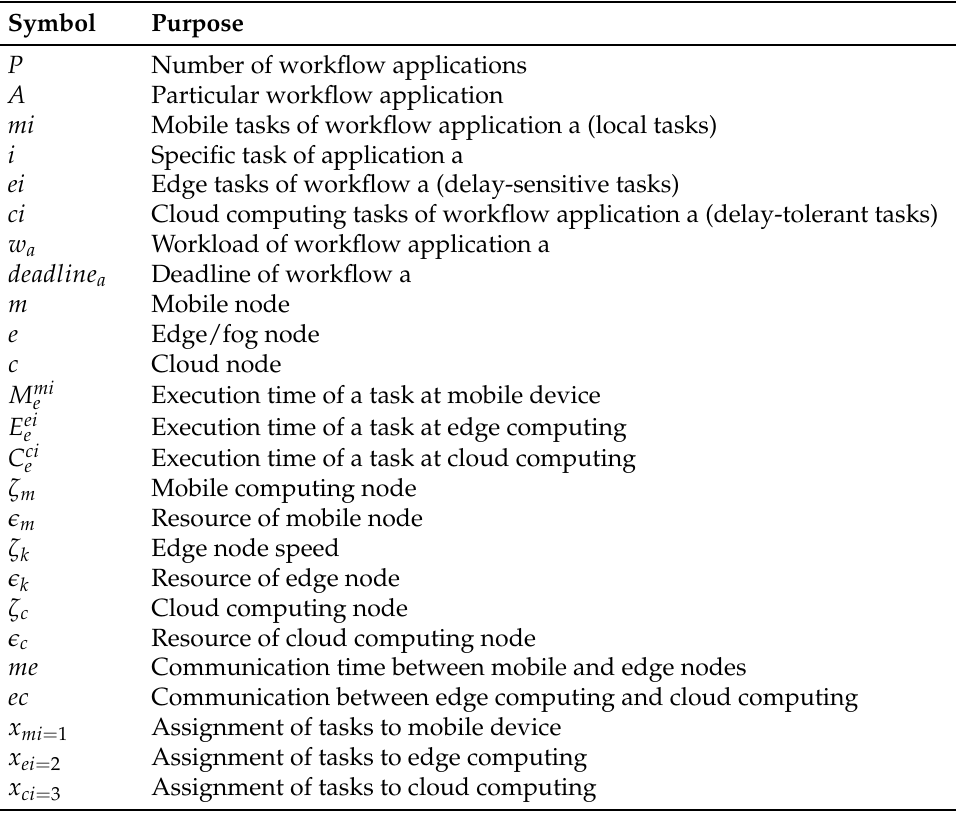
Table 2. Problem